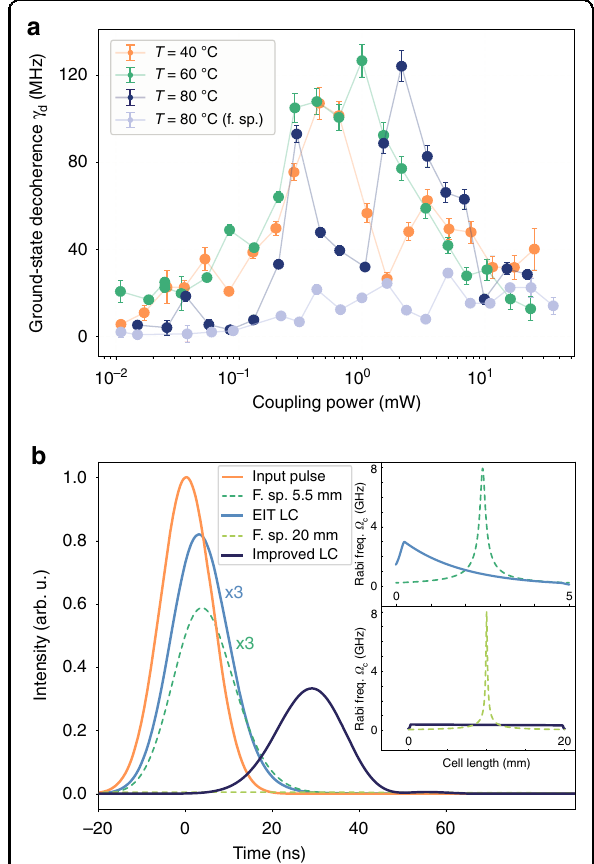
Fig. 4 Decoherence in LC and prospects for EIT delay. a Derived ground-state decoherence γ d as a function of the coupling laser power for different temperatures in the LC compared to free space (f.sp.). b Simulated transmission of a Gaussian light pulse with 14 ns width (orange) through the 4.5mm long LC (5mm vapour cell). The solid light blue curve corresponds to the loss of our experiment. The dashed green line shows the delay in free space. The Rabi frequency along z is displayed in the top inset for both f.sp (dashed) and LC (solid). For comparison, the delay of an improved LC 40 with reduced loss α LC / 100 and decoherence rate γ d = 100kHz is shown as a dark blue curve. Rabi frequency along z in this improved LC (bottom inset, solid line) and corresponding f.sp. (bottom inset, dashed line) are shown as